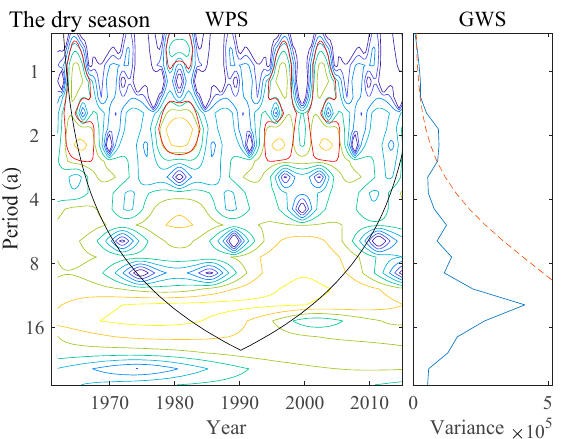
Figure 12. The runoff wavelet power spectrum and global wavelet spectrum for Dawenkou station.